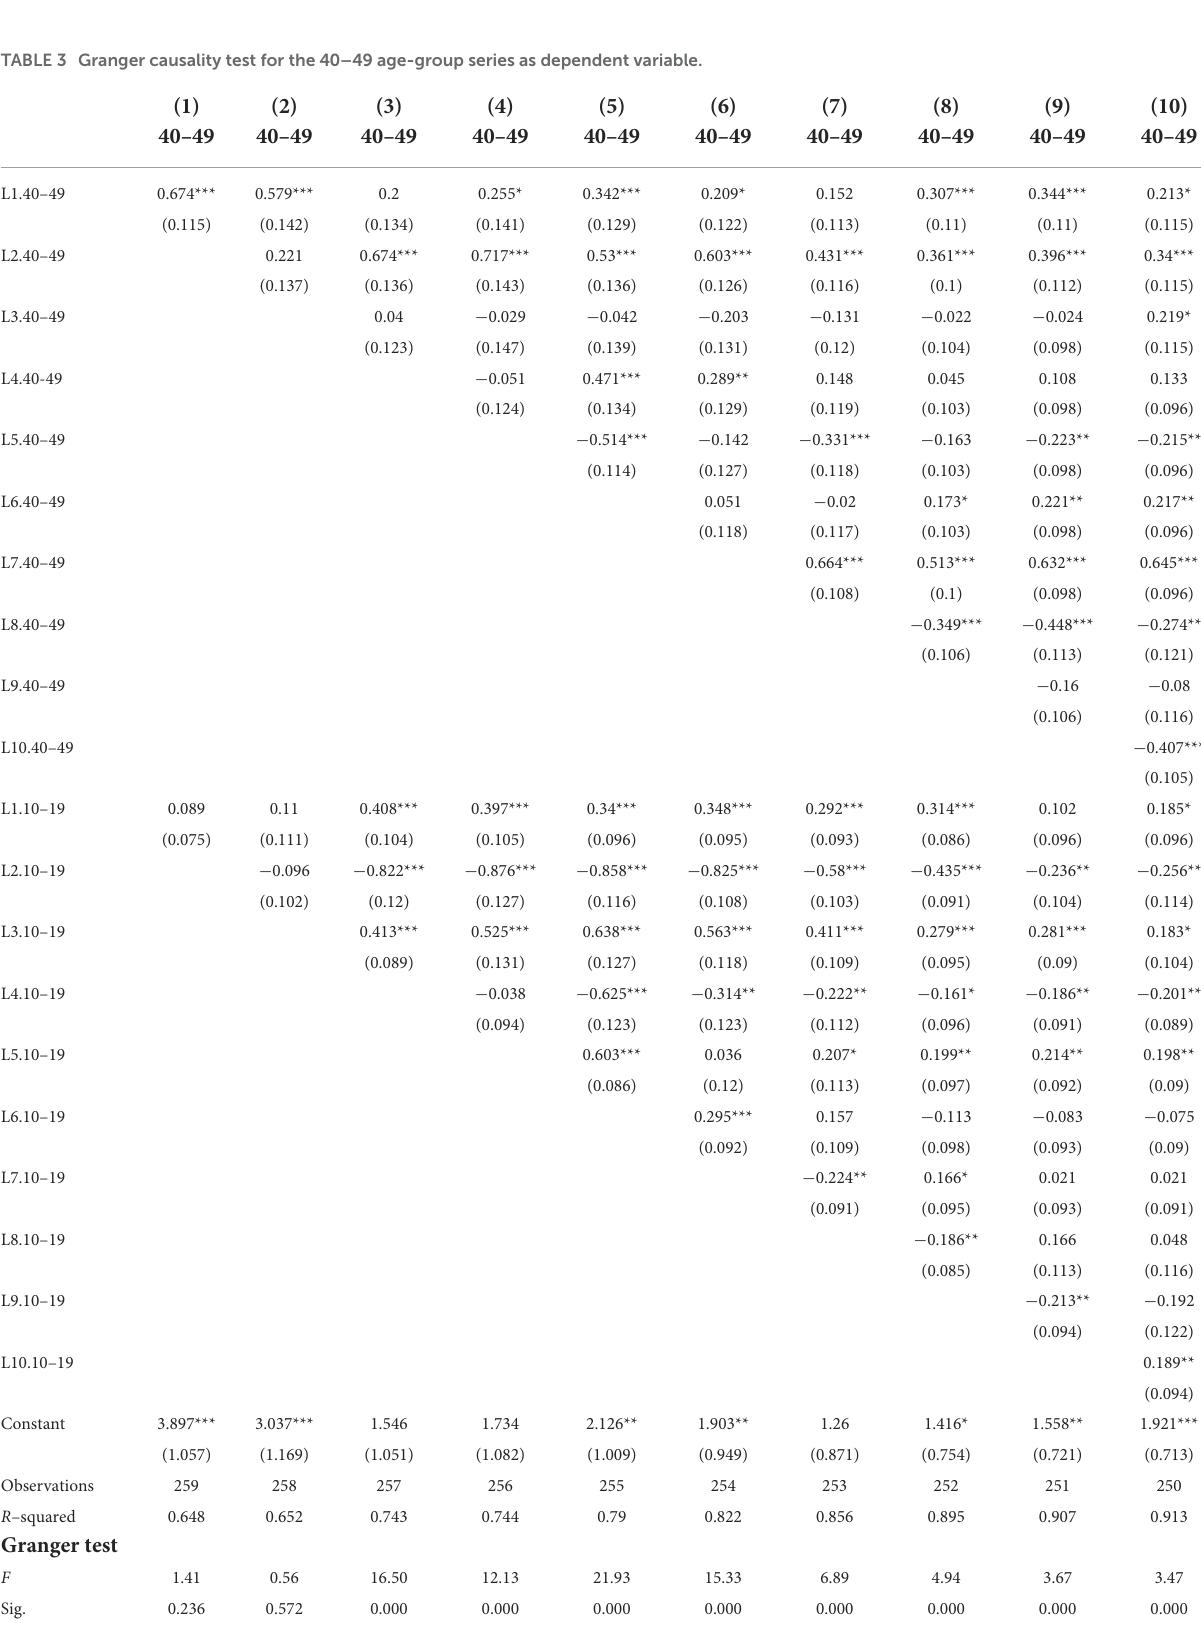
TABLE 3 Granger causality test for the 40–49 age-group series as dependent